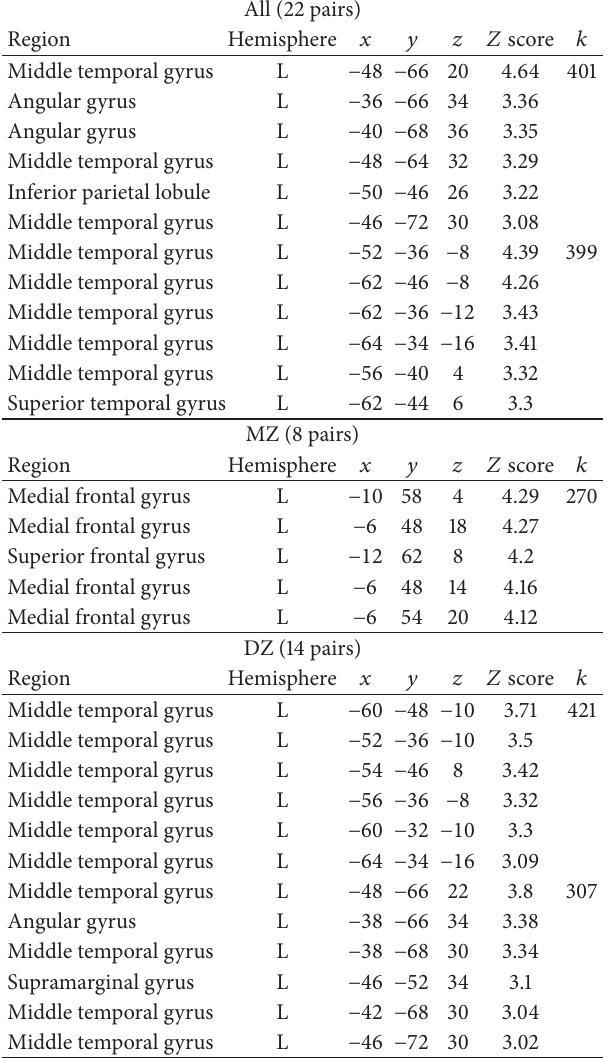
Table 3: Regions (and 𝑥 , 𝑦 , and 𝑧 coordinates) associated with reduced activation in type 2 diabetes.